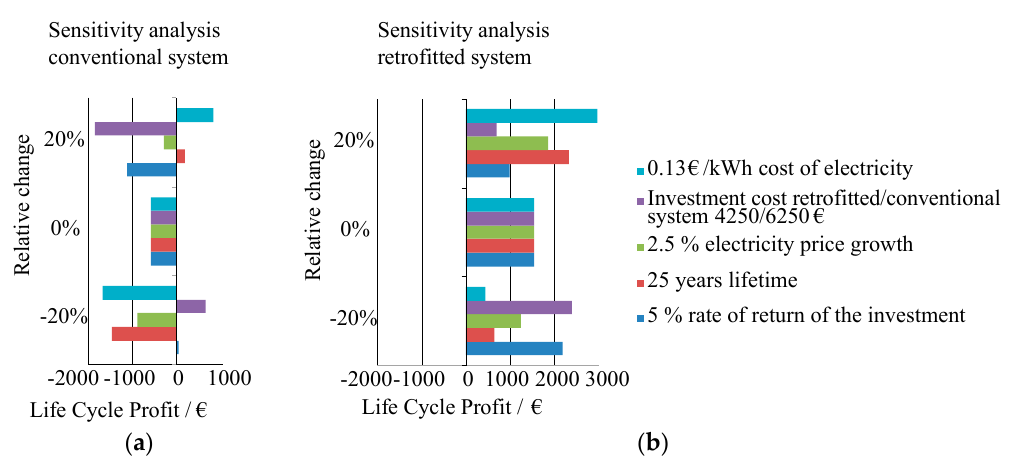
Figure 10. Results of the sensitivity analysis on several input parameters regarding the life cycle profit for the ( a ) conventional solar domestic hot water system; and ( b ) retrofitted solar domestic hot water system.